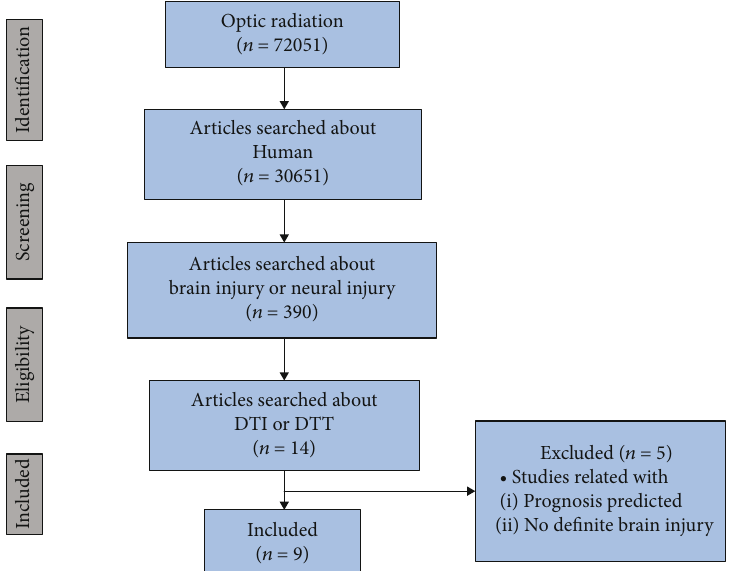
Figure 1: Flow diagram of optic radiation study selection (DTI: di ff usion tensor imaging; DTT: di ff usion tensor